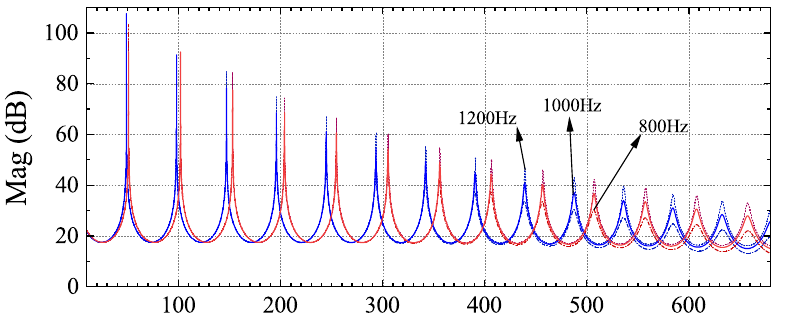
Figure 8. Proposed RC magnitude response when the cutoff frequency of low-pass filter